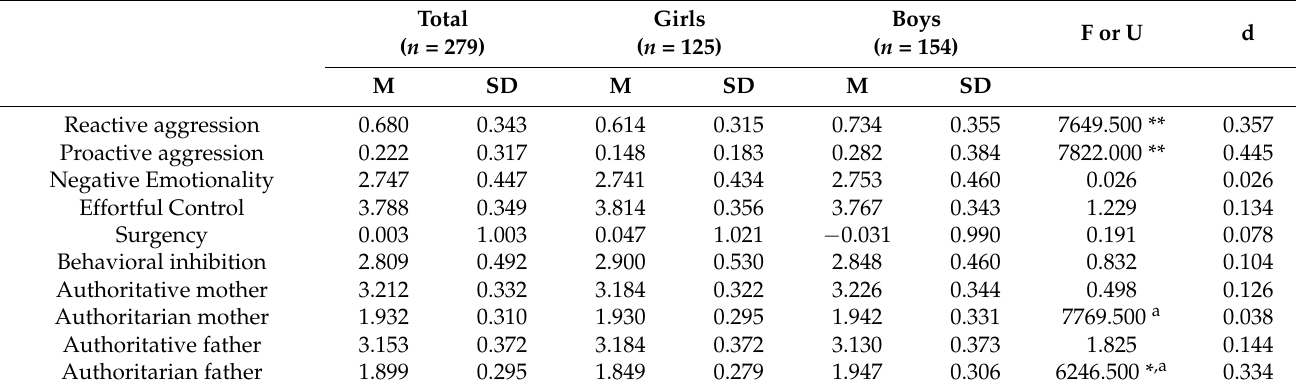
Table 1. Sex differences, means and standard deviations.